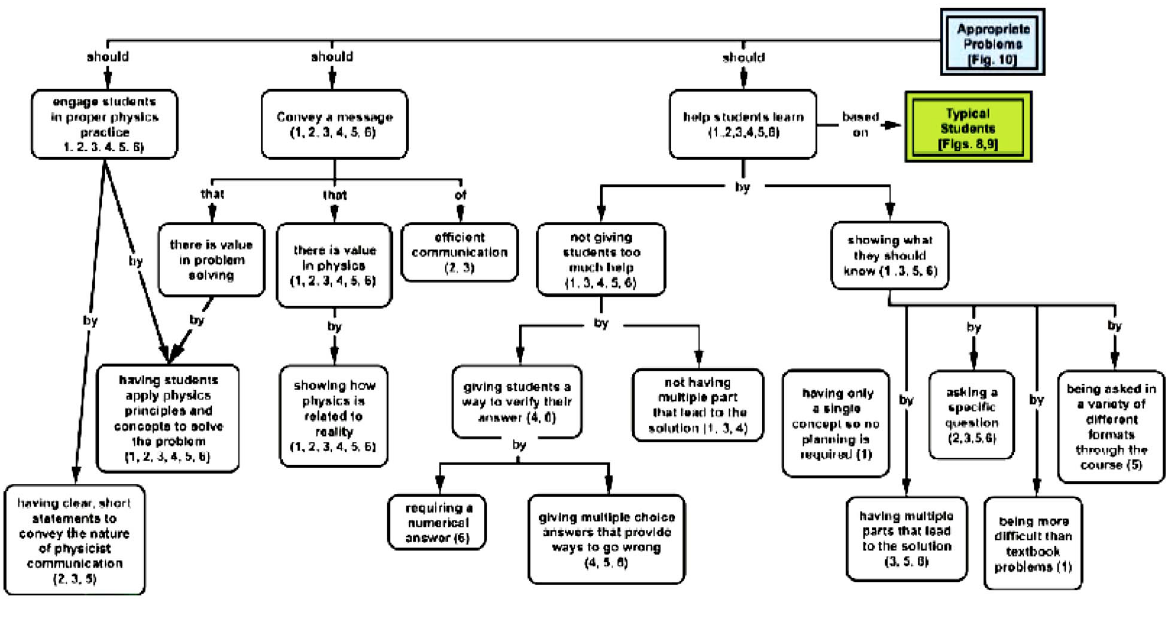
FIG. 10. (cid:1) Color (cid:2) Values part of composite map “Appropriate Problems” concerned with faculty beliefs about the appropriate structure of problems in their introductory physics course. Numbers in the parentheses denote the instructor whose statements directly justify that category. The boxes framed with a double line indicate principal categories that are elaborated in other composite